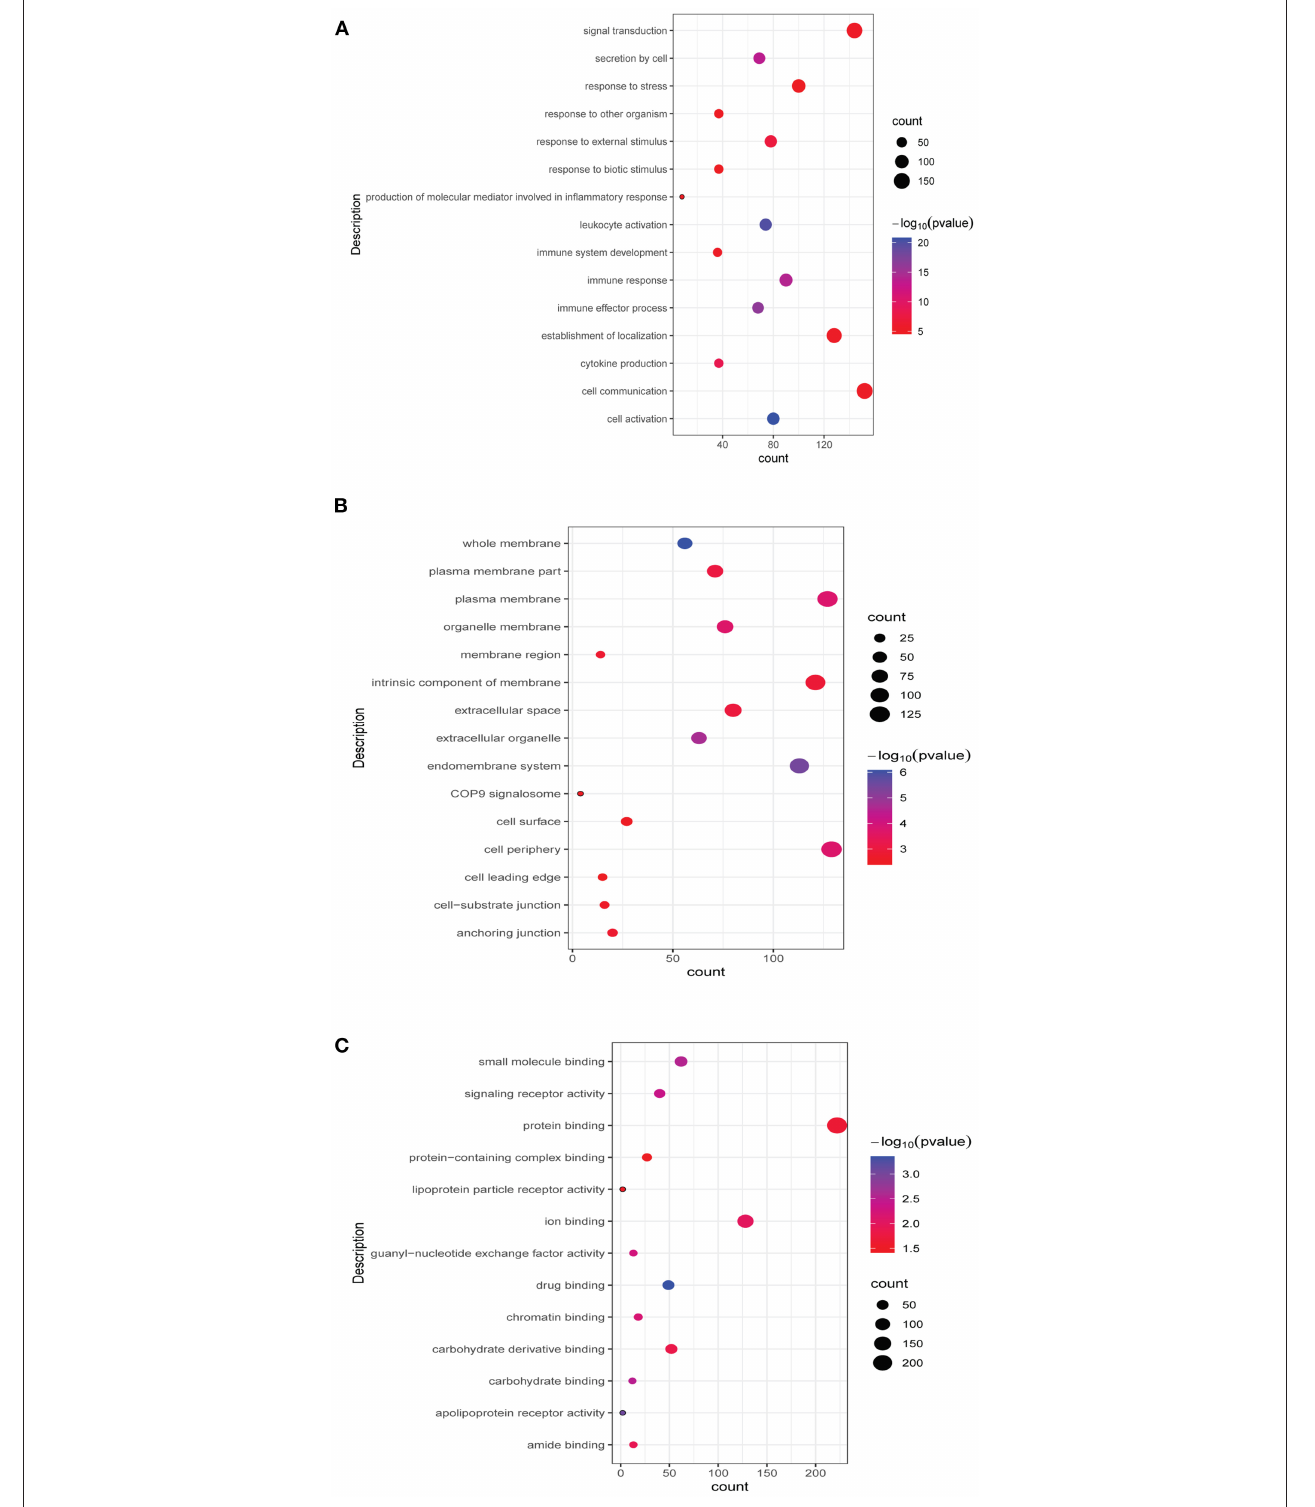
FIGURE 3 | Top 15 significant enrichment GO terms of common differentially expressed mRNAs between MF vs. AMI and HF vs. MF. The x -axis and y -axis present the number of enriching mRNAs and GO terms, respectively. (A) , biological progress; (B) , cellular component; (C) , molecular function.